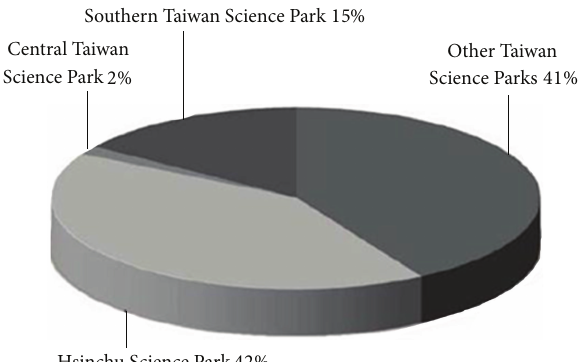
Figure 7: Revenue percentage of the Taiwanese solar photovoltaic industry (by Taiwan science parks). Source: PIDA (2012)